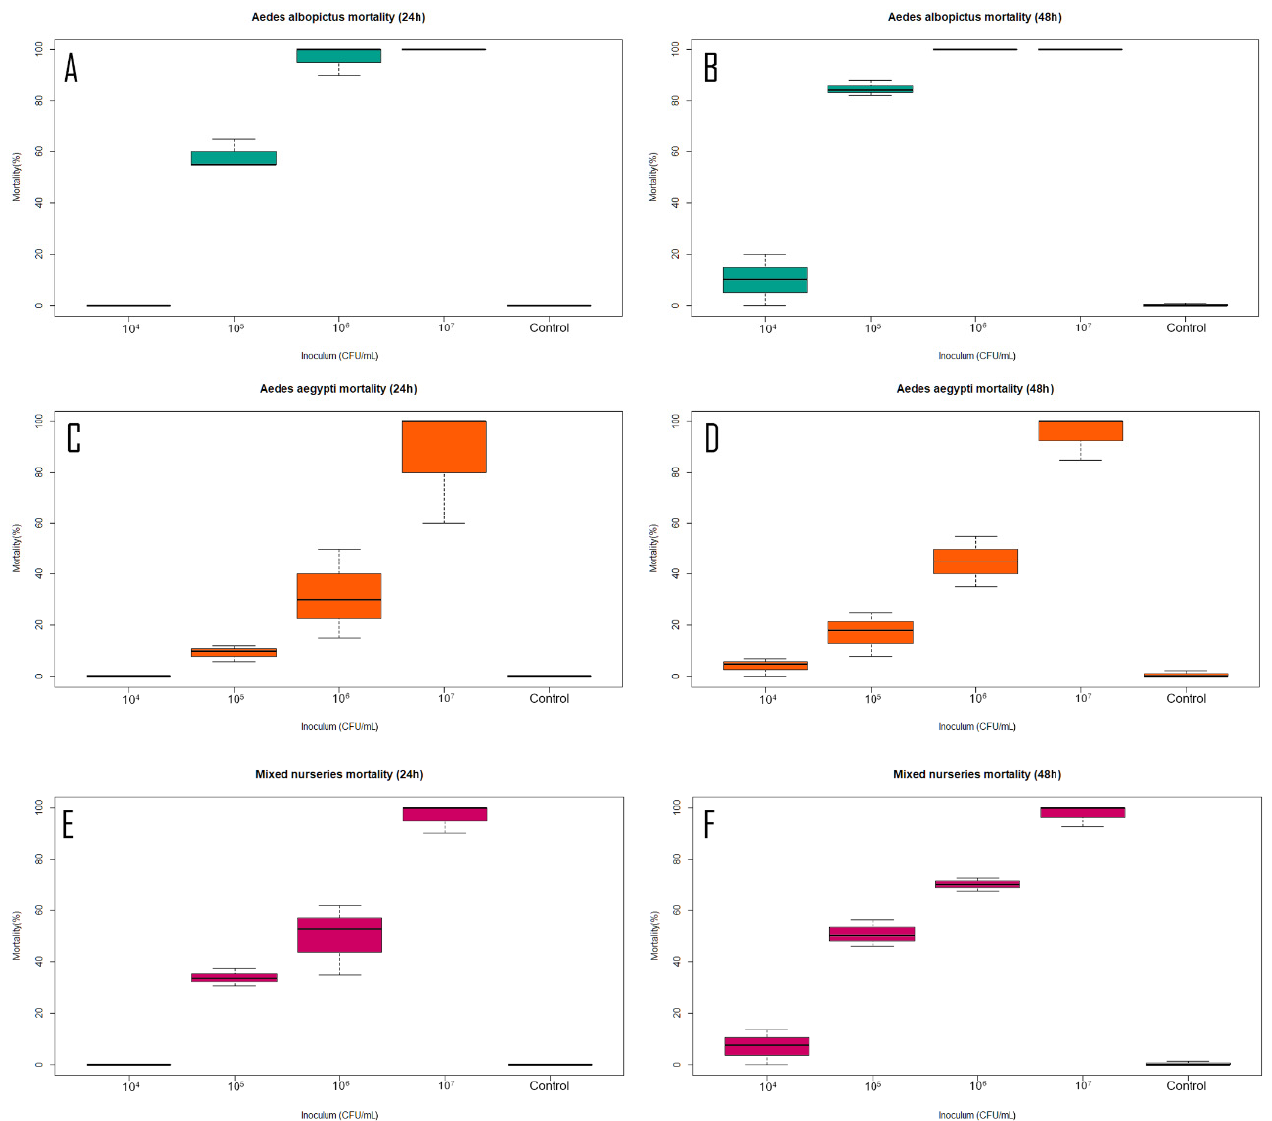
Figure 2. Dose-dependent responses of the different Aedes nurseries when exposed to the different inoculum concentrations used at the set time intervals. ( A ) Aedes albopictus nurseries (24 h post inoculation). ( B ) Aedes albopictus nurseries (48 h post inoculation). ( C ) Aedes aegypti nurseries (24 h post inoculation). ( D ) Aedes aegypti nurseries (48 h post inoculation). ( E ) Mixed nurseries (24 h post inoculation). ( F ) Mixed nurseries (48 h post